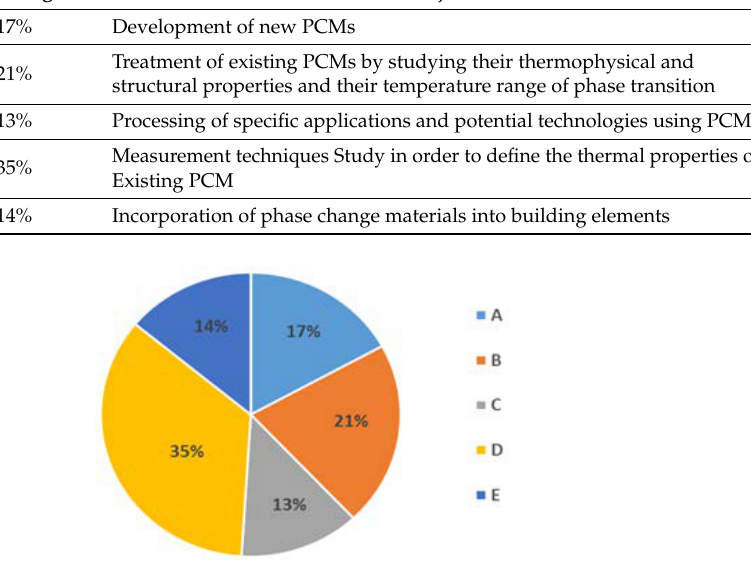
Figure 7. Topics dealing with PCM use in buildings.